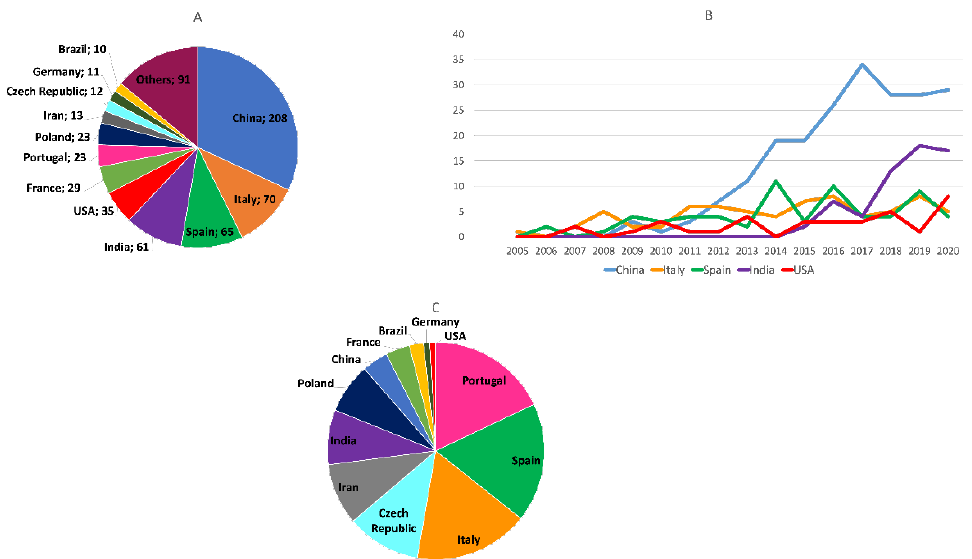
Figure 6. ( A ) Geographical origin of the articles on multitarget anti-AD compounds in the period 1990–2020, considering the total number of published articles; ( B ) evolution of the total number of original research articles on multitarget anti-AD compounds coming from the top five contributor countries in the period 1990–2020; ( C ) geographical origin of the articles on multitarget anti-AD compounds in the period 1990–2020, considering the total number of articles normalized by the number of researchers in each country.